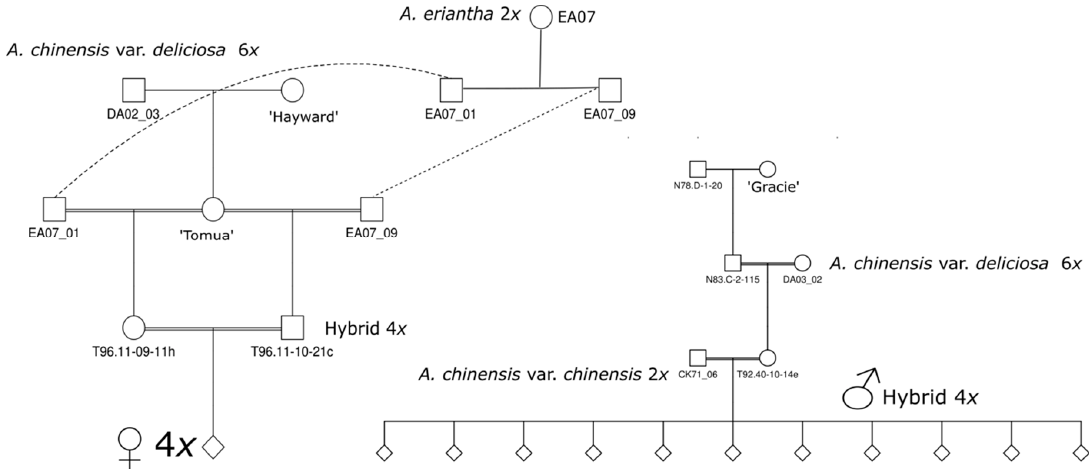
Figure 2. Pedigrees and ploidies of maternal parent (L) and of A. chinensis var. deliciosa × A. chinensis var. chinensis males (R) used to generate families used for pooled sequencing.